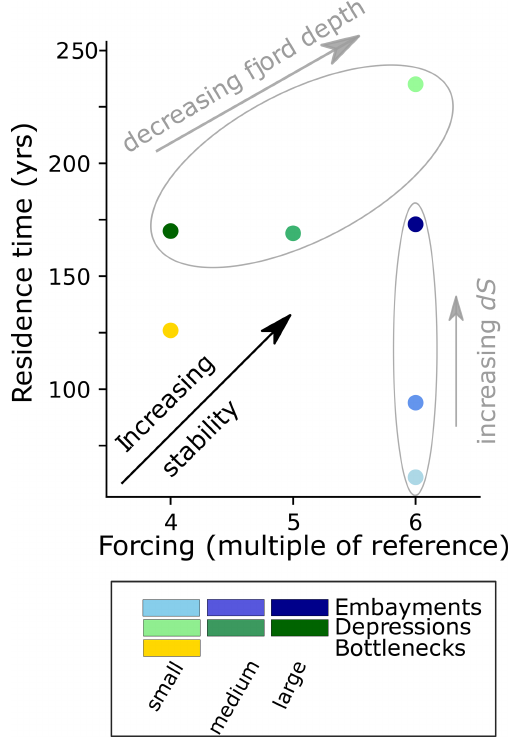
Figure 4. Forcing required to induce complete retreat in multiples of the reference forcing (200myr − 1 undercutting rate, 30myr − 1 subshelf melt) and approximate residence time of the GL in a stag- nant position for different fjord geometries. A longer residence time and a larger forcing required indicate that fjord geometry provides larger stability. More stability is correlated with decreasing fjord depth for depressions (shades of green) and with increasing along- fjord change in wetted area d S for embayments (shades of blue). The simulations for which no retreat through the perturbation was observed have been omitted from the